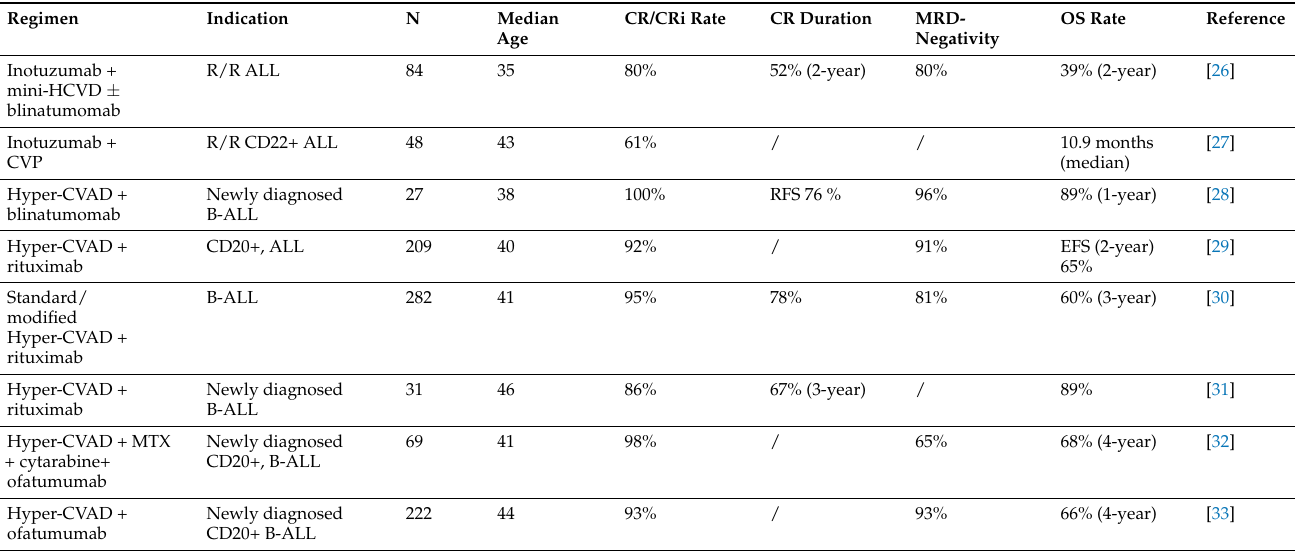
Table 3. Combination studies for adult Ph-negative